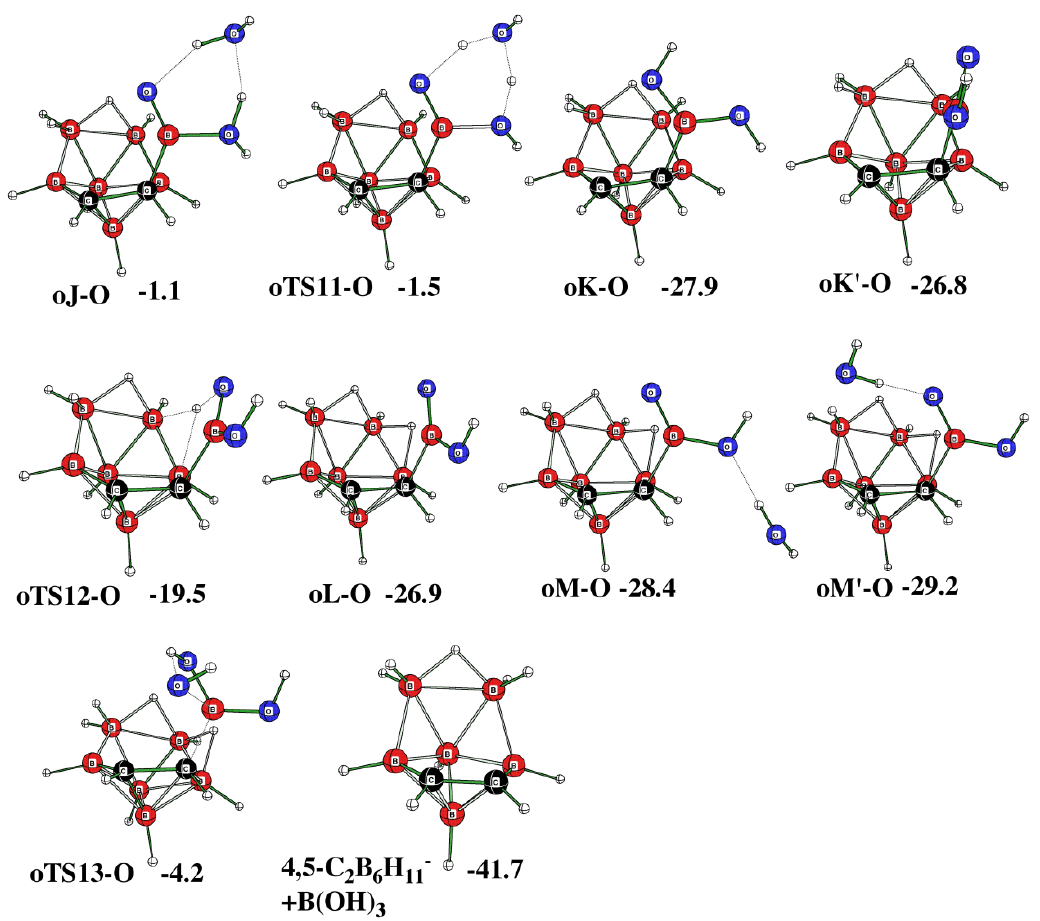
Figure 1. Individual stationary points as determined in the reaction pathway of the reaction of closo -1,2-C 2 B 8 H 10 with OH ( − ) .